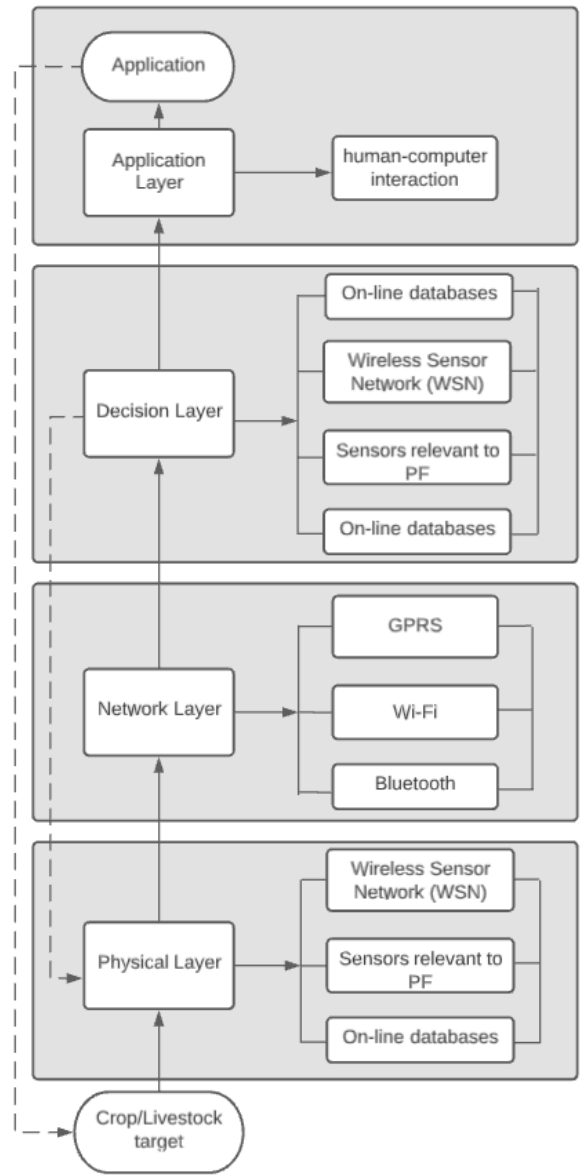
Figure 5. MAR agricultural application framework adapted from [12].